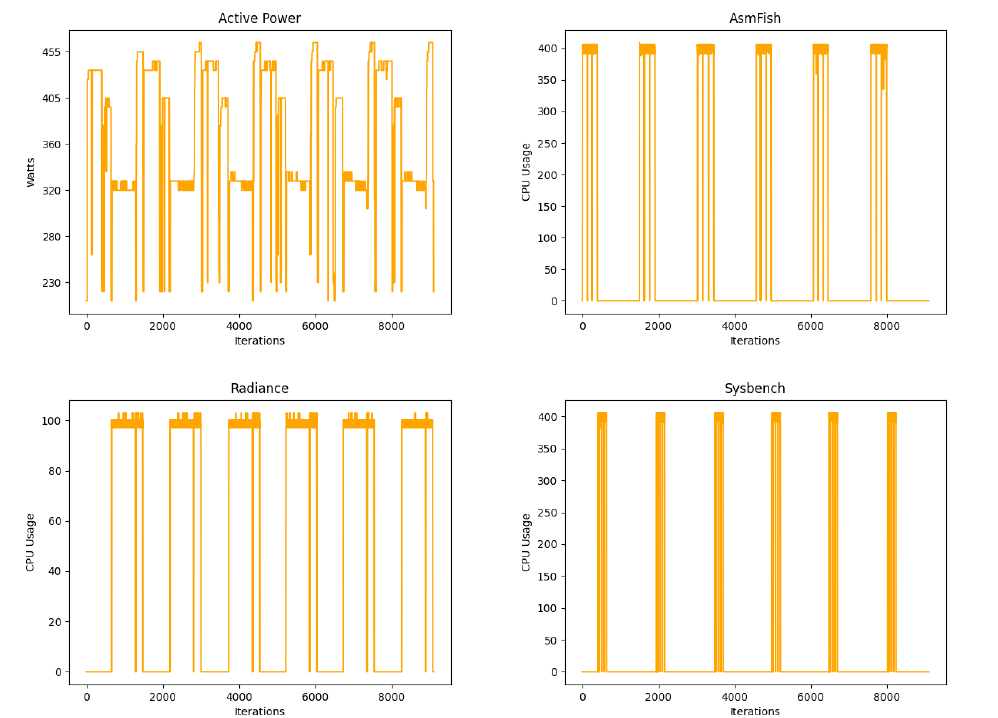
Figure 12. Energy characteristic measurement distribution: ( Top left ) Active Power distribution.